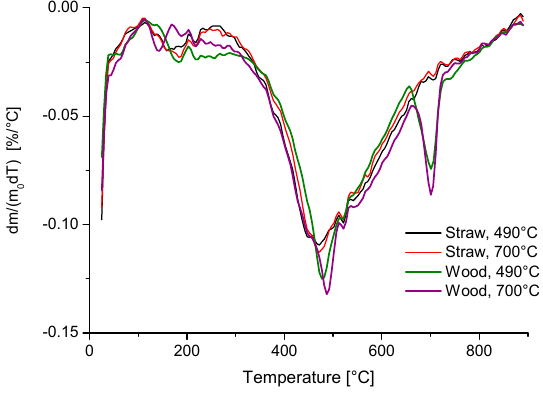
Figure 13. DTG of thermal treated hydrochars of beech wood and straw at 490 and 700 °C, respectively. (Modified from [21]).